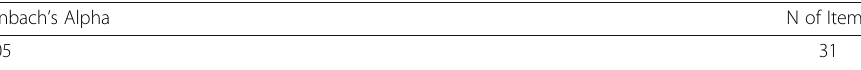
Table 1 Reliability